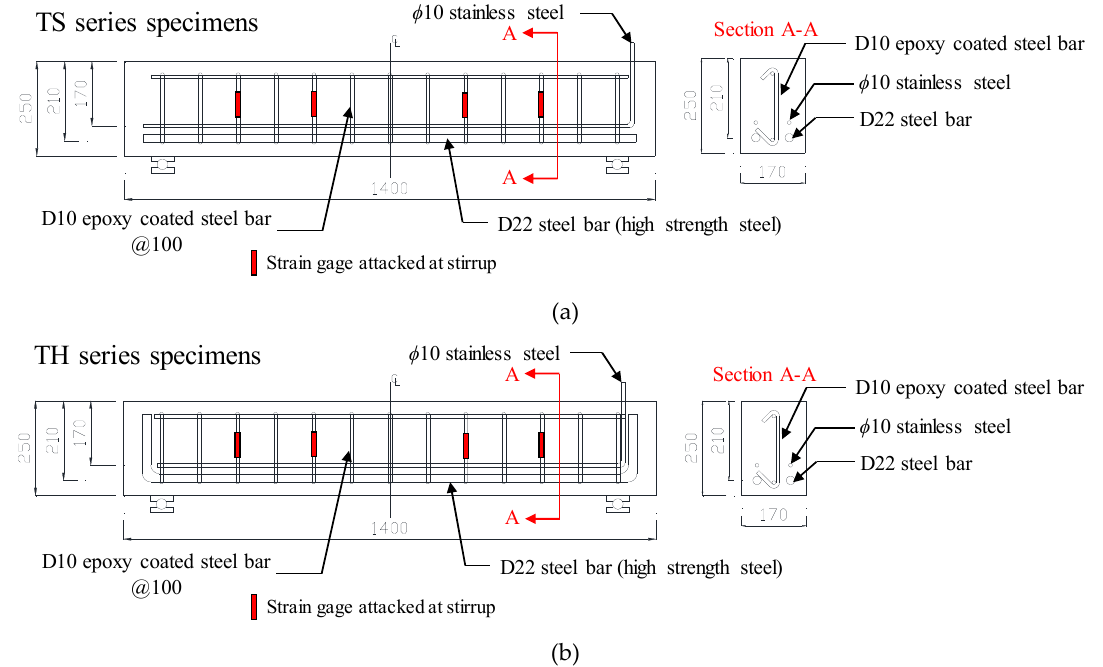
Figure 1. Details of test specimens (Unit: mm). ( a ) TS series specimens; ( b ) TH series specimens.